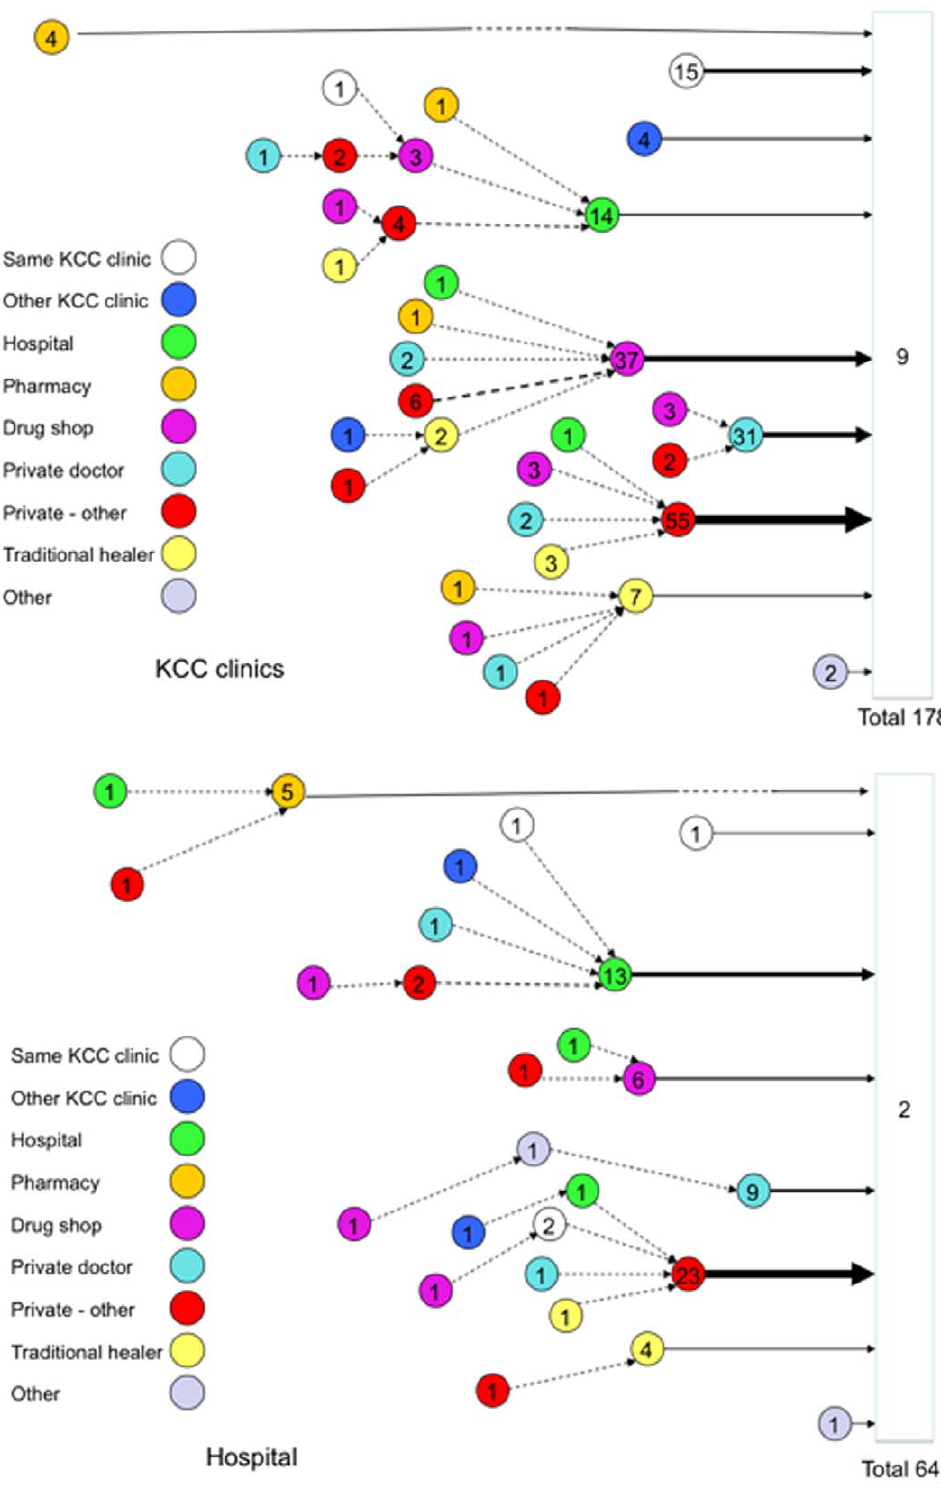
Figure 2. Patients’ trajectories through the health system. Legend: The figure shows the health service delay of the patients from the last step of provider before the patient is finally diagnosed with TB. Length of the arrow is equivalent to the length of the delay drawn on scale. Other arrows are not drawn to scale. They just indicate the direction of patient’s movement in search of the health care. The width of the arrow represents the number of patients who go from one point to the next. The number in the circles are the total number of patients that start from that point together with those that go through that care provider. In the hospital 2 patients did not experience health service delay. Nine patients did not experience health service delay at the KCC clinics. KCC=Kampala City Council.